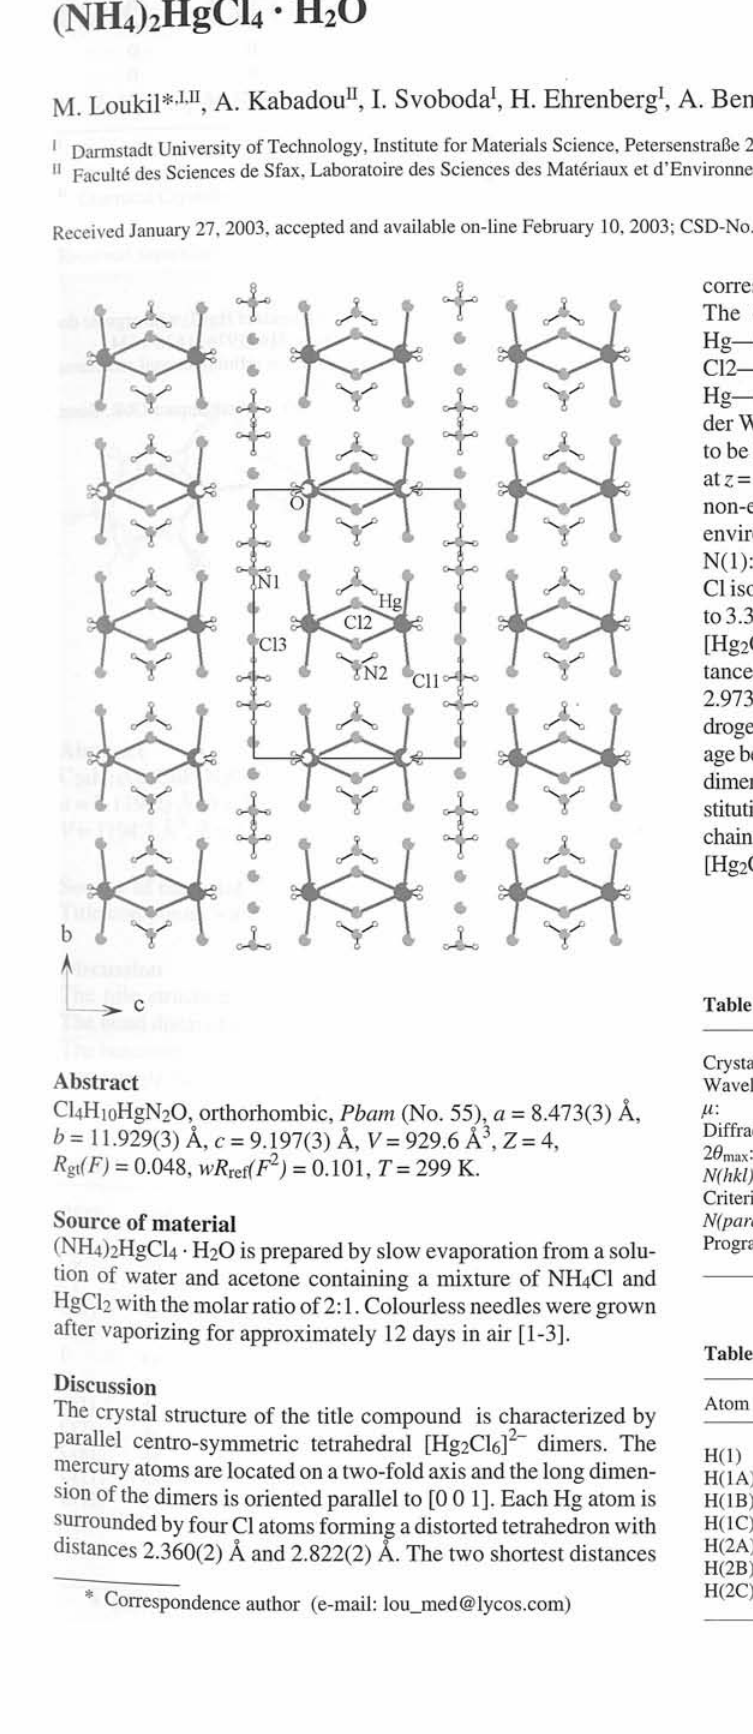
Table 2. Atomic coordinates and displacement parameters (in Â 2